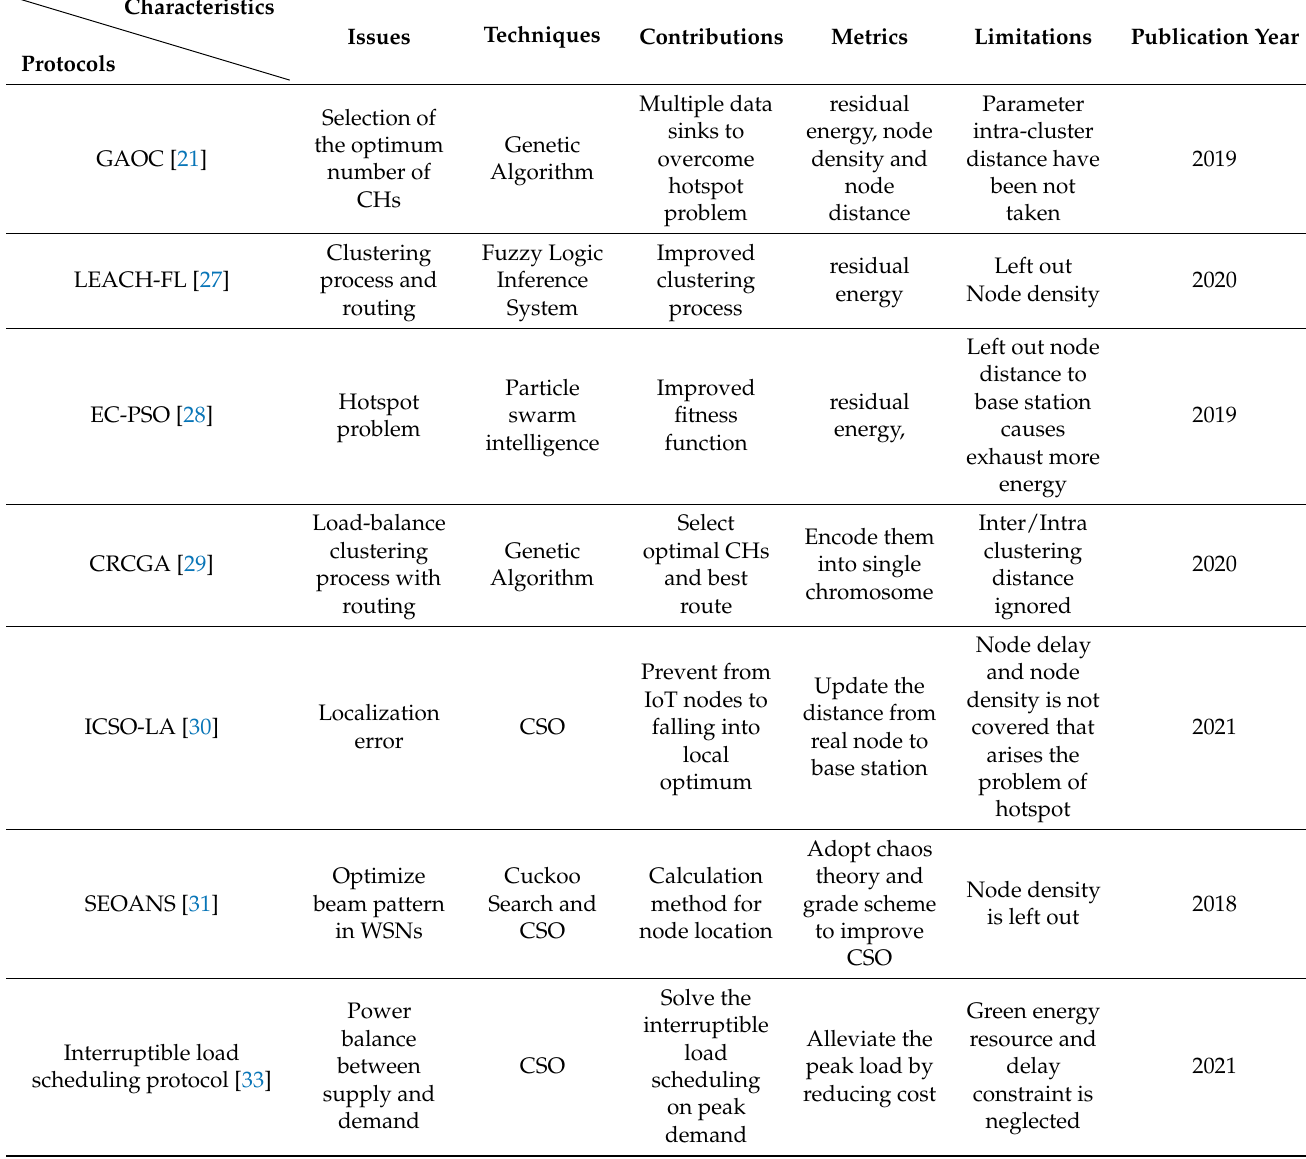
Table 1. Comparative study of recent research